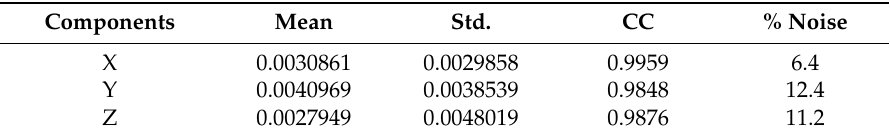
Table 1. Statistical mean and standard deviation (Std) values of the RMS differences in m/s 2 between the kinematic accelerations for receivers A and B in Figure 2. The correlation coefficients (CC (A,B)) between the datasets of the two receivers are also listed with the related % noise contributions from Equation (2).